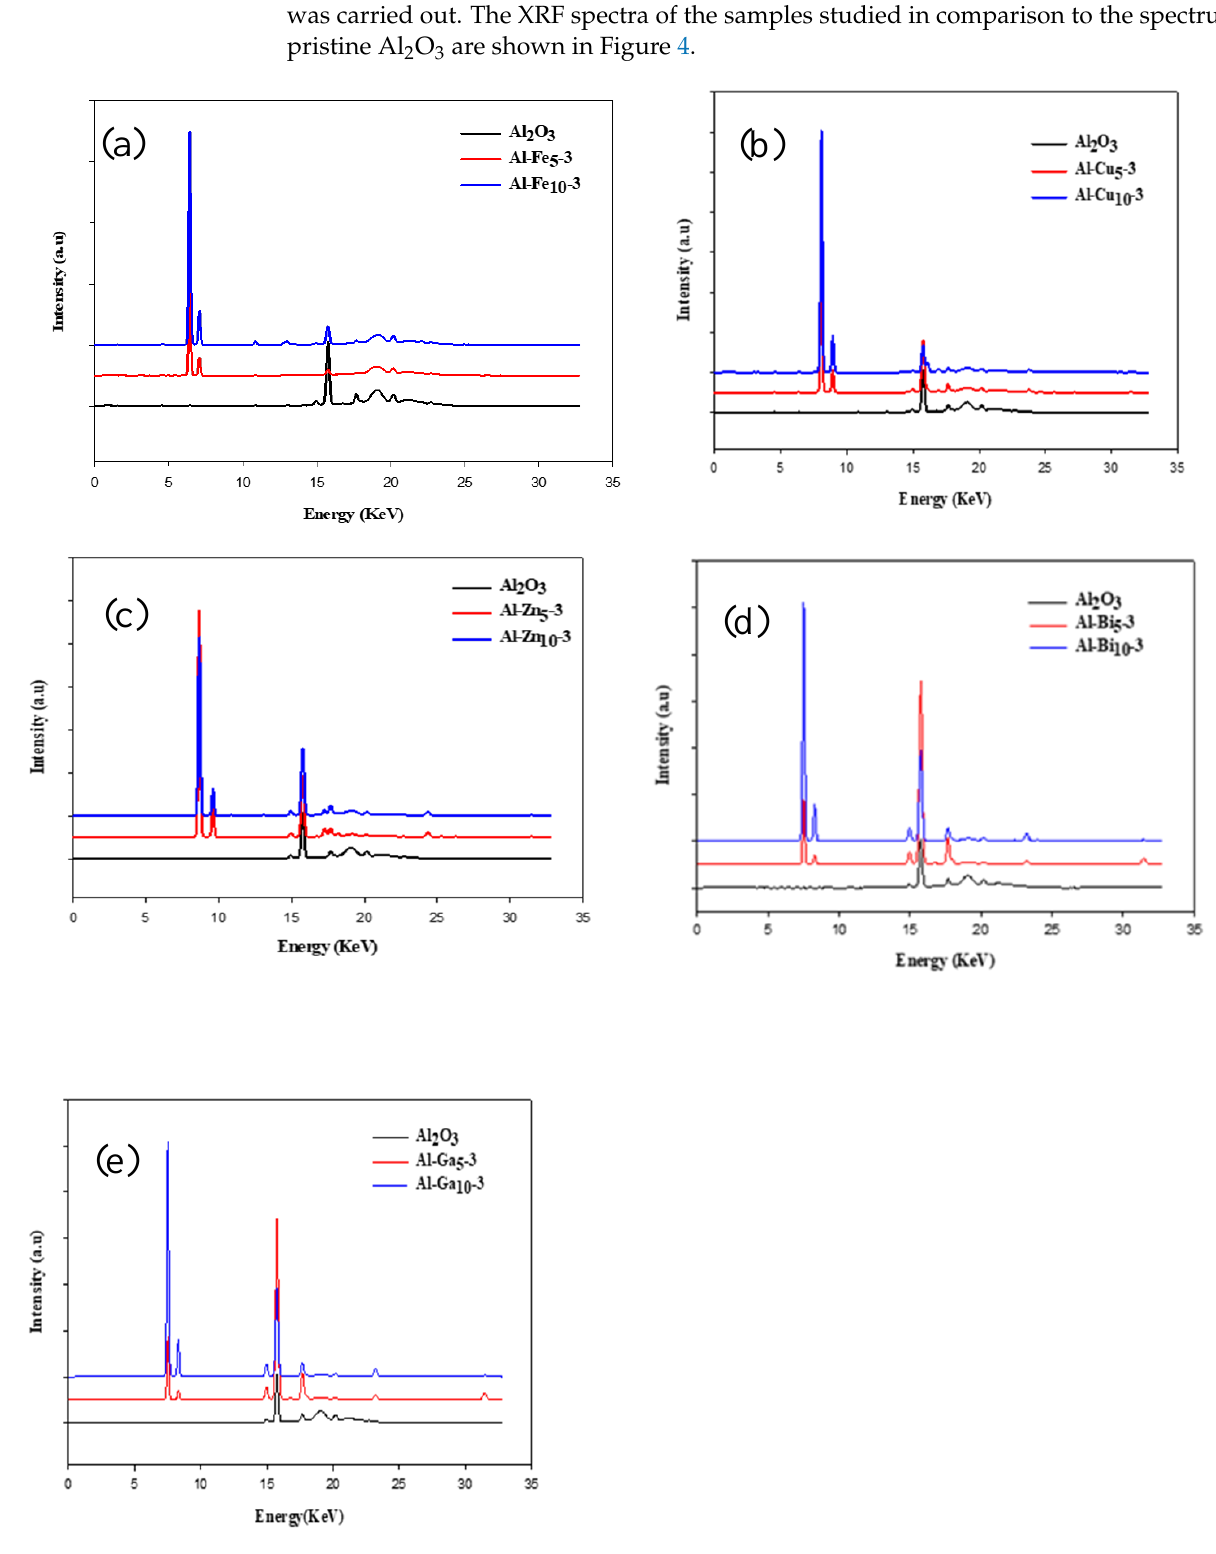
Figure 3. TEM images of Al-Fe 5 -3 ( a ), and Al-Fe 10 -3 ( b ) indicating the presence of disordered but quite uniform mesopores.